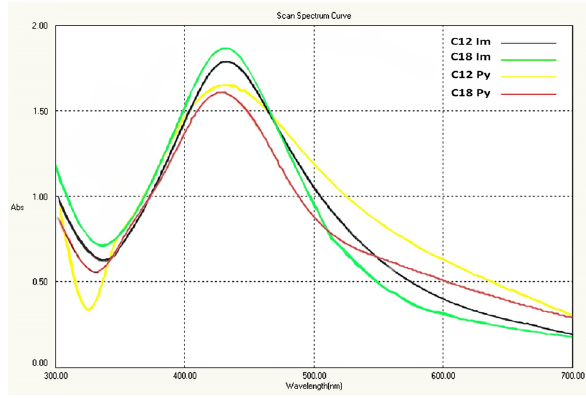
Figure 1: UV - visible spectroscopy of di ff erent ionic liquid - coated Ag nanoparticles.